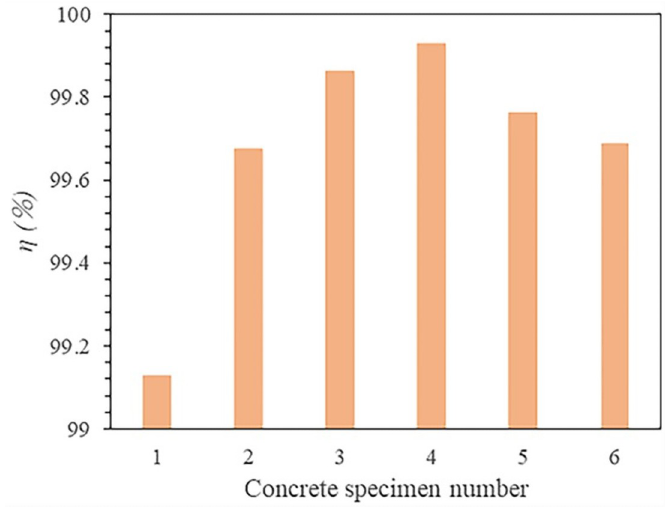
Fig 11. The torque work ratio during the drilling process of concrete specimens with different strengths.